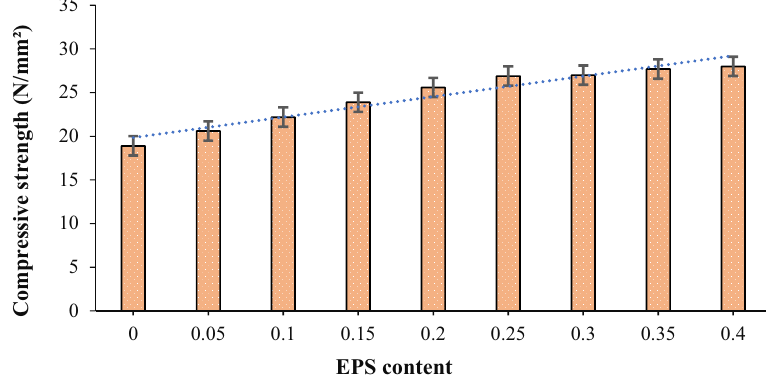
Figure 1: Compressive strength at 28 days of EPS - AC with di ff erent EPS